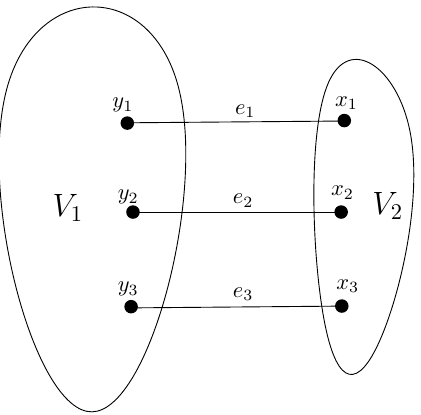
Figure 2. An edge 3-cut of G for which ∣ V 2 ∣ attains minimum